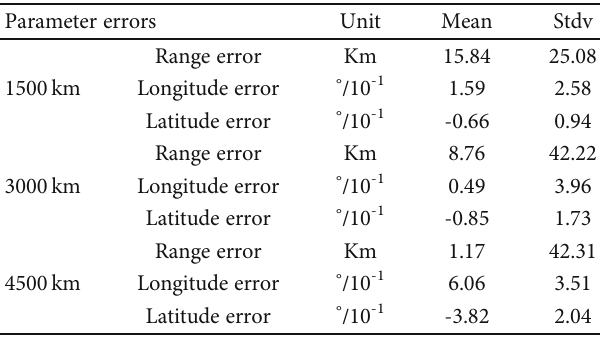
Figure 8: Pro fi les of the state parameters of 750 Monte Carlo runs under di ff erent missions. (a) Altitude. (b) Flight path angle. Table 2: Statistics results of 750 Monte Carlo runs for solid rockets under di ff erent